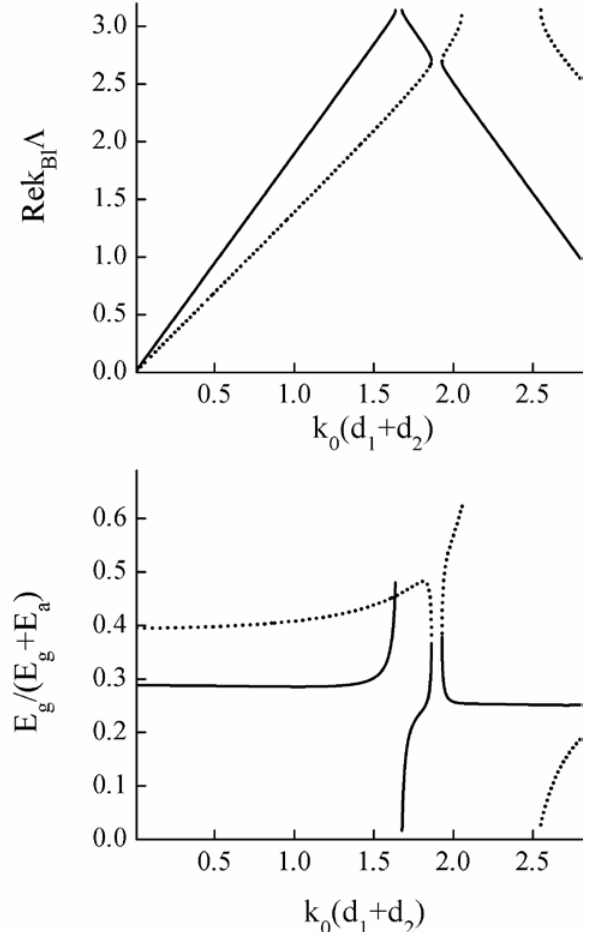
Figure 15. (Top figure) Dispersion curves of the PC with one anisotropic and one gyrotropic layer in a period. (Bottom figure) The relative part of the energy of the Bloch waves concentrated in the gyrotropic PC layers. Solid and dotted curves correspond to two different Bloch modes. The degenerate BG forms around the frequency Only the parts of curves that lie in pass bands are